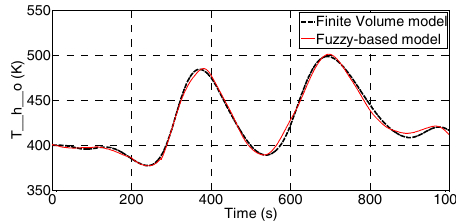
Figure 15. Comparison of heat source outlet temperature of fuzzy-based and FV models. Table 5. Performance of fuzzy-based dynamic evaporator model.